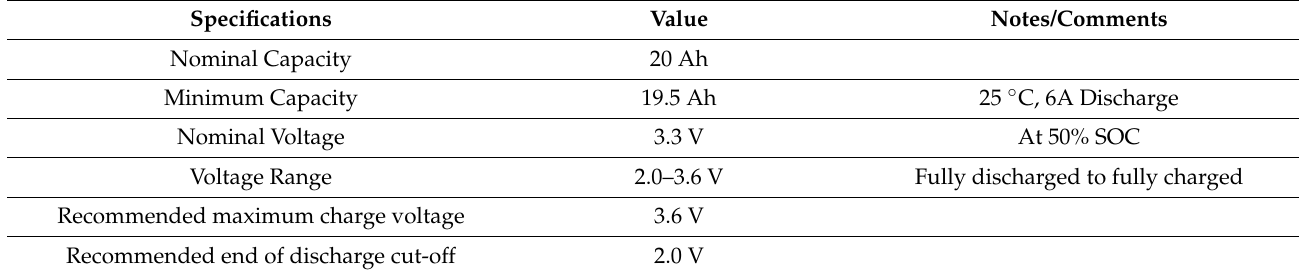
Figure 9. ( a ) Battery discharge C-rate and ( b ) SOC for the entire run. Table 3. Datasheet of A123 cells considered for the design.